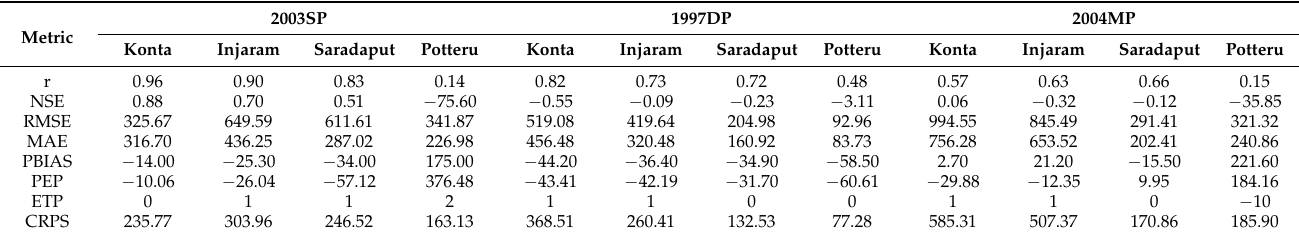
As the need for the basin-wide real-time forecast is imminent, reliable and accurate runoff estimates at customized locations of a basin including ungauged basins are neces- sary. The estimation of streamflow for the interior part of a basin requires a scientific un-